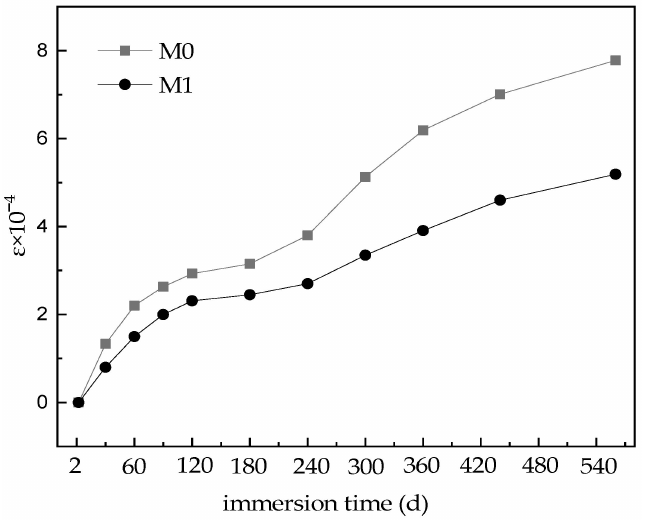
Figure 2. Volumetric deformation of MKPC specimens with water immersion